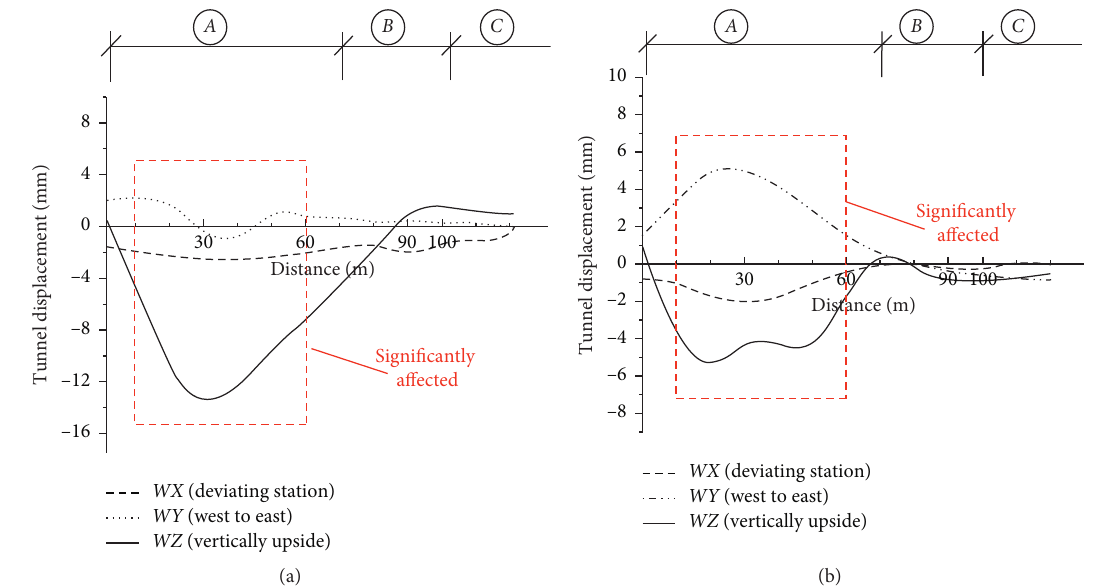
Figure 10: Variations in tunnel displacement: (a) westbound tunnel and (b) eastbound tunnel.